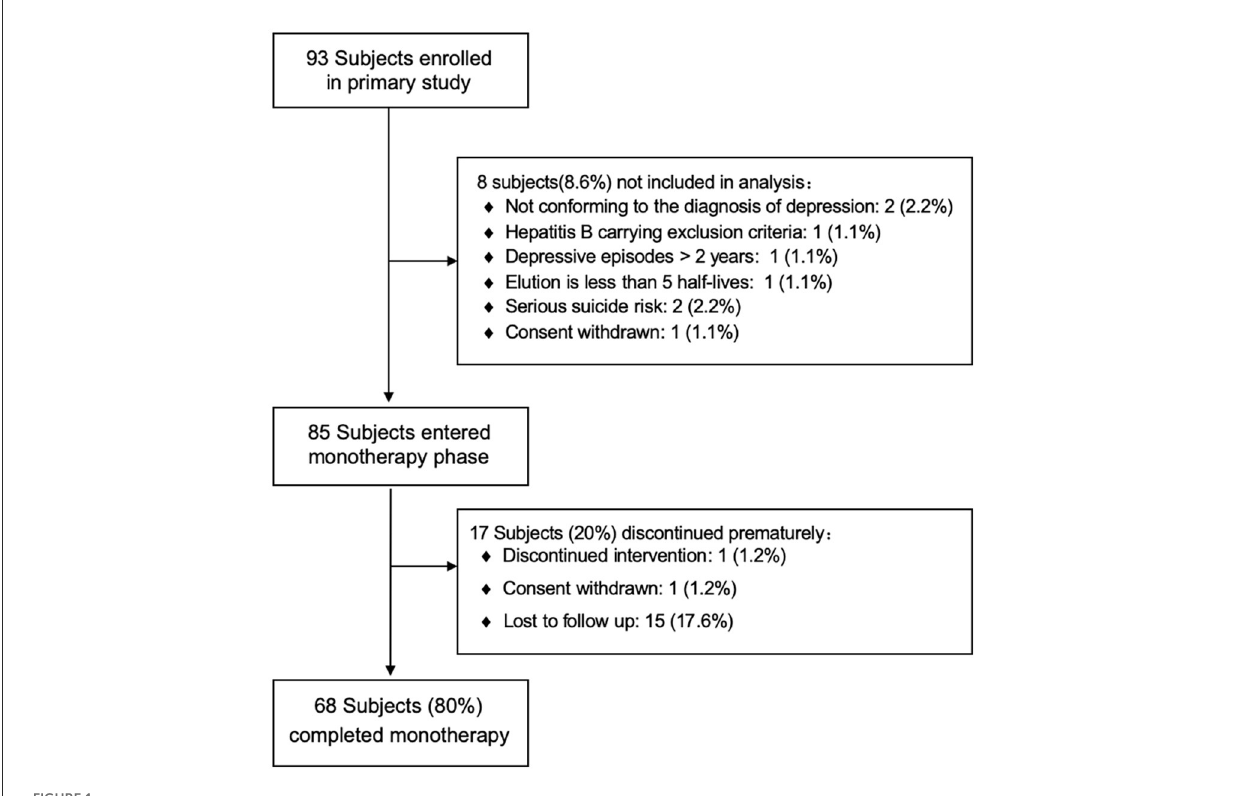
FIGURE1 Flow chart of the study procedure.